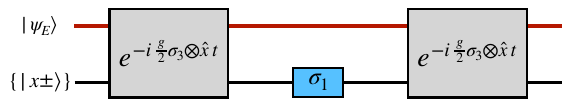
FIG. 28. A CP-divisible but non-Markovian process. A qubit system is prepared in states | x ±(cid:16) and evolves along with an environment. The uninterrupted dynamics of the system is pure dephasing, which is certified as Markovian by two-point wit- nesses. However, when an instrument X is applied at time t , the system dynamics reverse and the system returns to its original state, which is only possible in the presence of non-Markovian